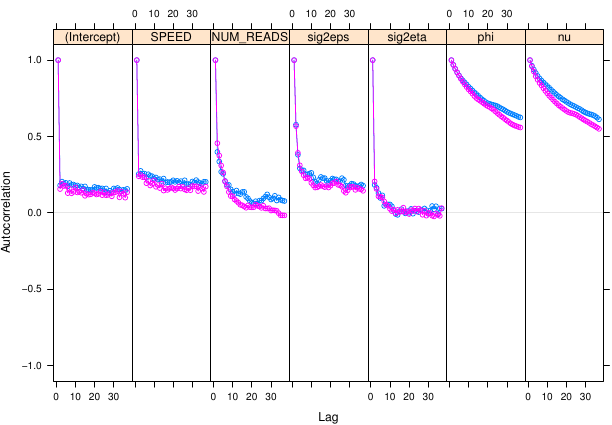
Figure 8. The autocorrelation coefficient estimation using two different lists of MCMC chains in the GP model.